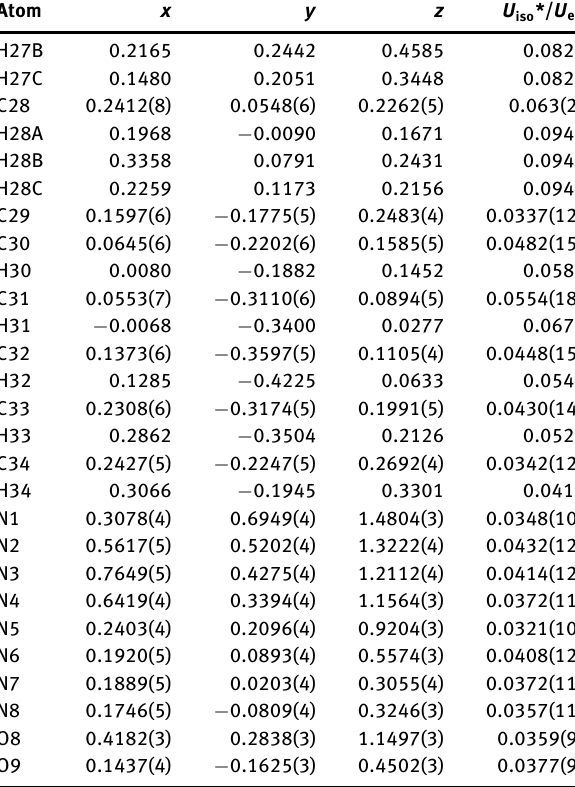
Table 2: Fractional atomic coordinates and isotropic or equivalent isotropic displacement parameters (Å 2